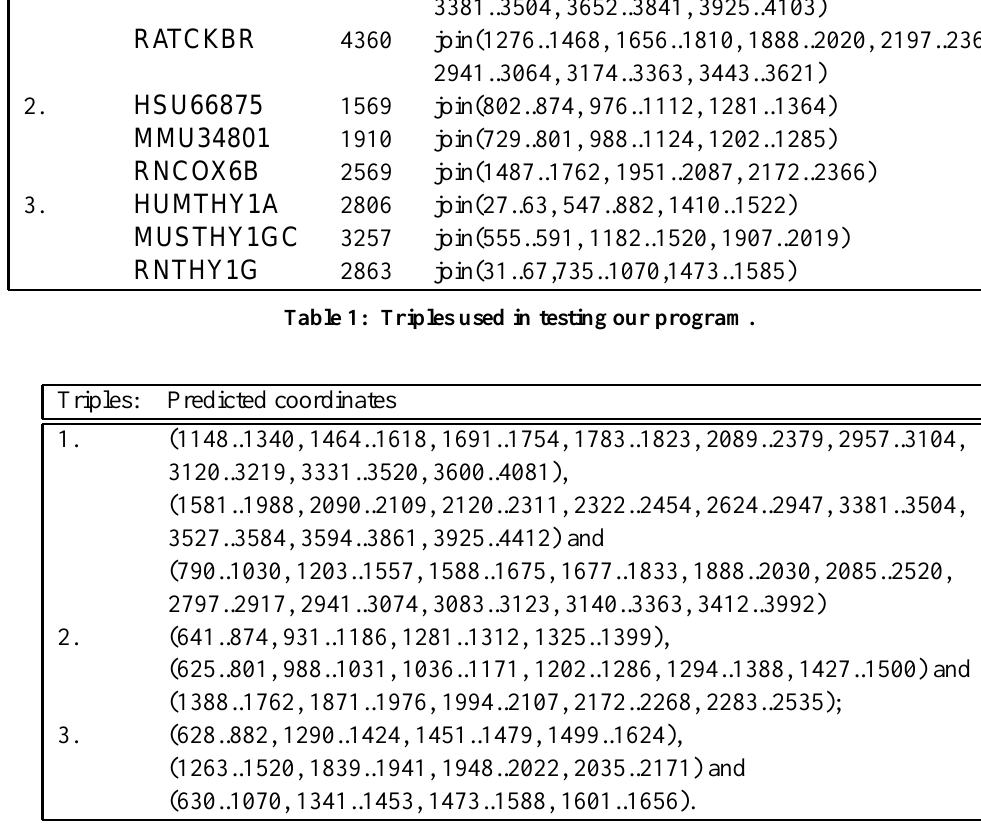
Table 2: Exons predicted by our program